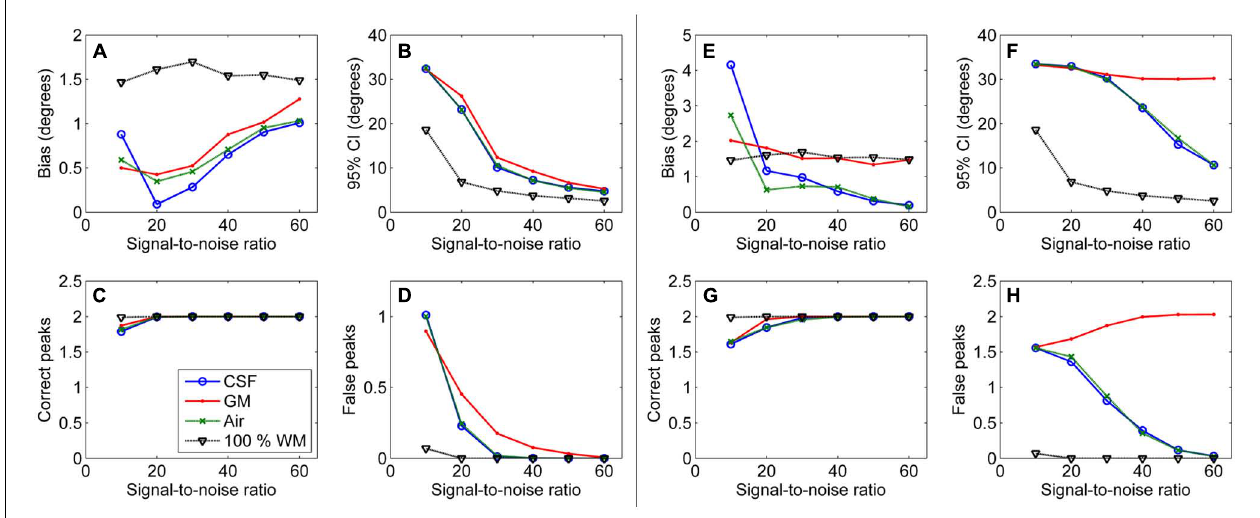
FIGURE 5 |The effect of varying SNRs with 50% (A–D) and 75% (E–H) non-WM partial volume (CSF, GM, and air) to bias, 95% confidence interval (CI), and the number of correct and false peaks